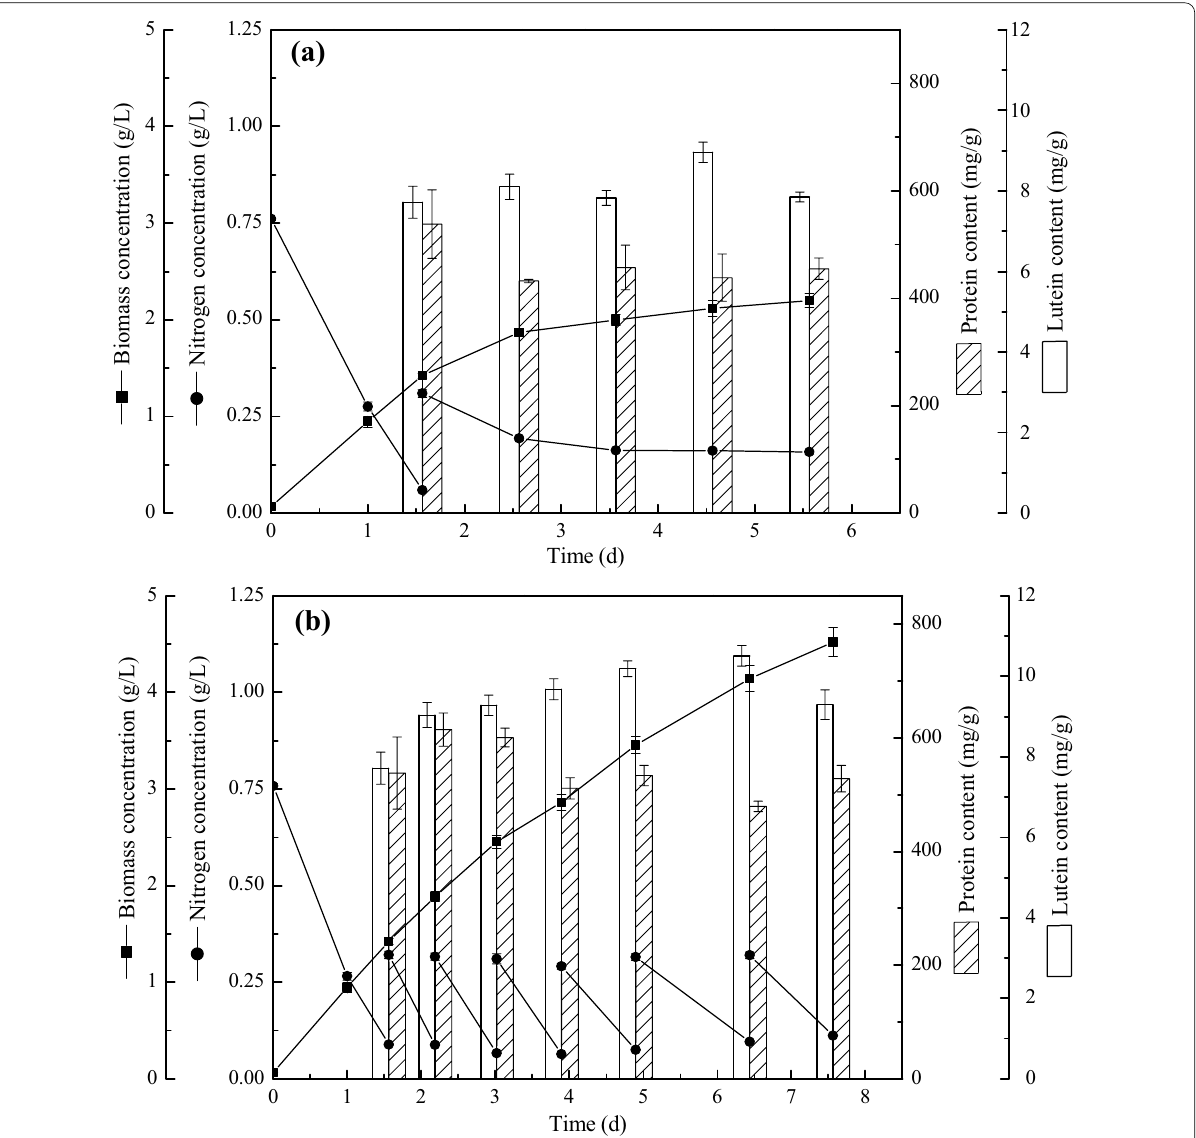
Fig. 3 Cell growth and lutein and protein accumulation of C. sorokiniana FZU60 under fed‑batch cultivation strategies. a Fed‑batch I strategy; b fed‑batch II